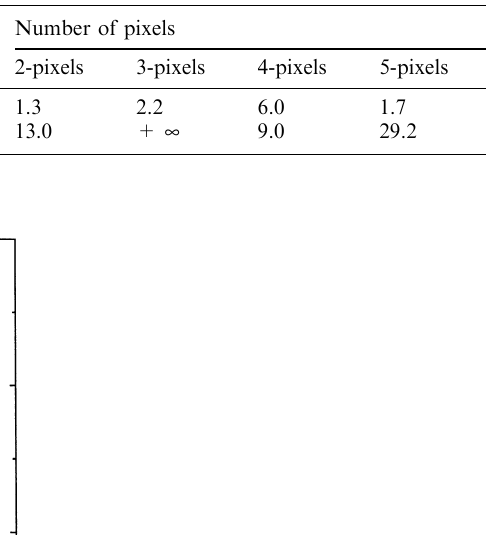
Fig. 4. Spherical particles and hexagonal crystals sampled with the PMS-2DC probe (17 February 1989)